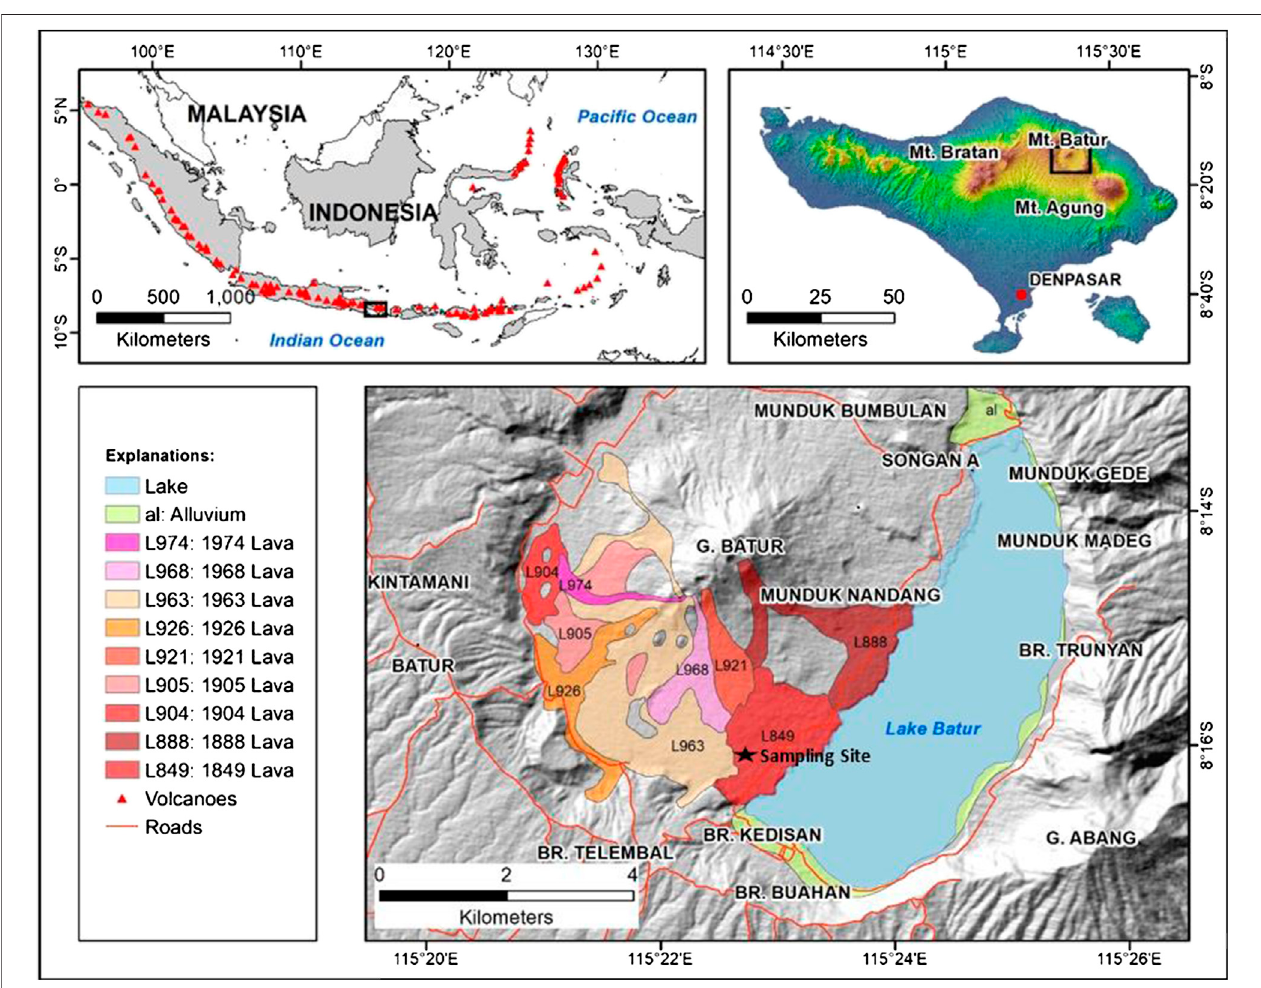
FIGURE 1 | Geological map of Batur Mountain (Sutawidjaja et al., 1992). Black point indicates the sampling location.